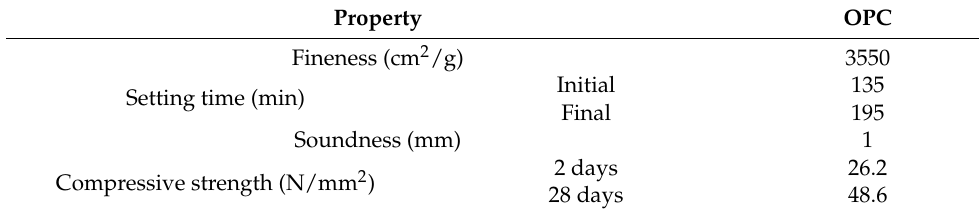
Table 4. The physical properties of the